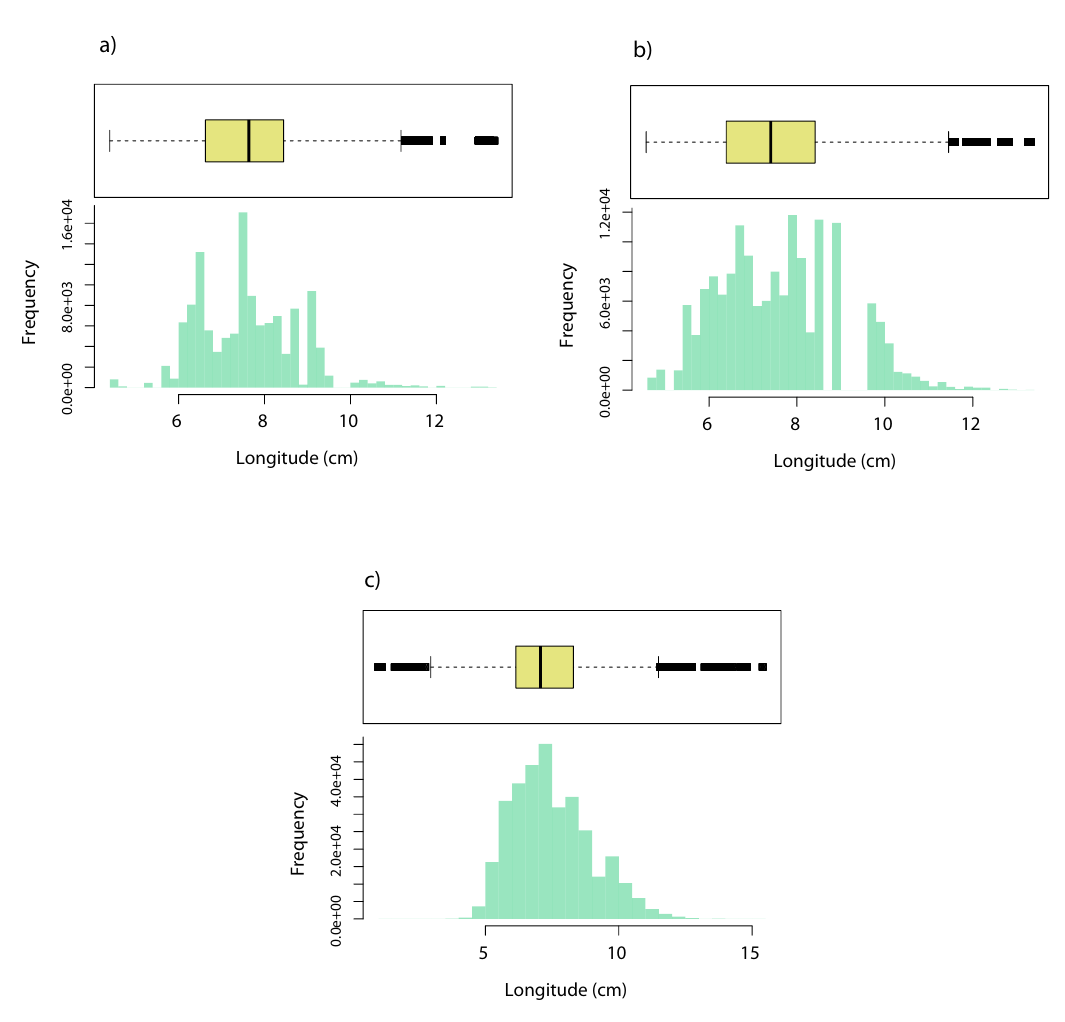
Figure 4. Distribution and boxplots of structures of sea urchin sizes in the three data subsets considered: Melinka Port ( a ), Quellón Port ( b ), and complete data excluding Melinka Port ( c